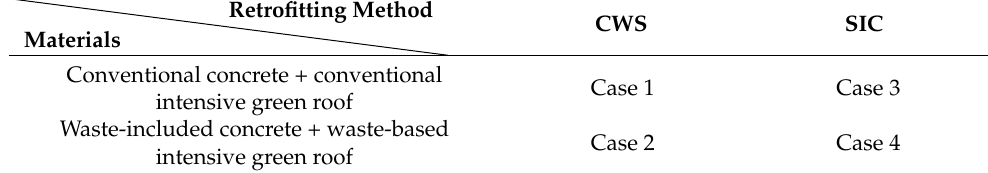
Table 1. Case studies.